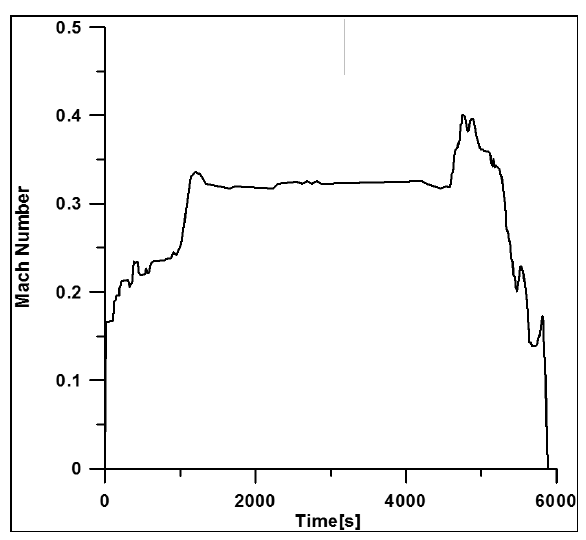
Figure 9. Mach number profile.